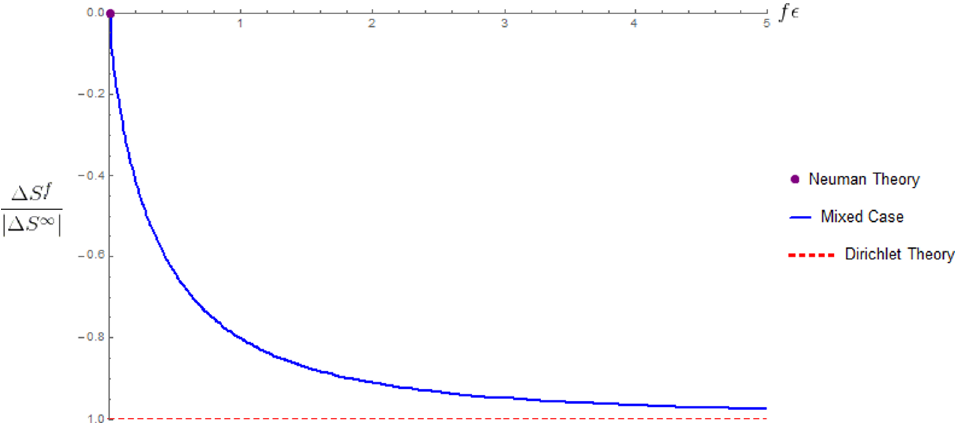
Figure 3 . This plot shows (cid:1) S f = j (cid:1) S 1 j vs. f(cid:15) for D = 4 and m 2 = 0. Notice it is decreases